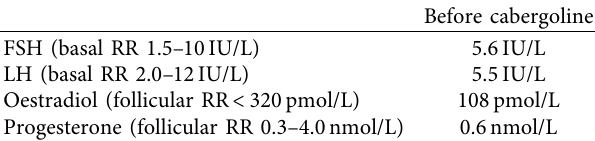
Table 1: Hormone levels of patient before cabergoline in this